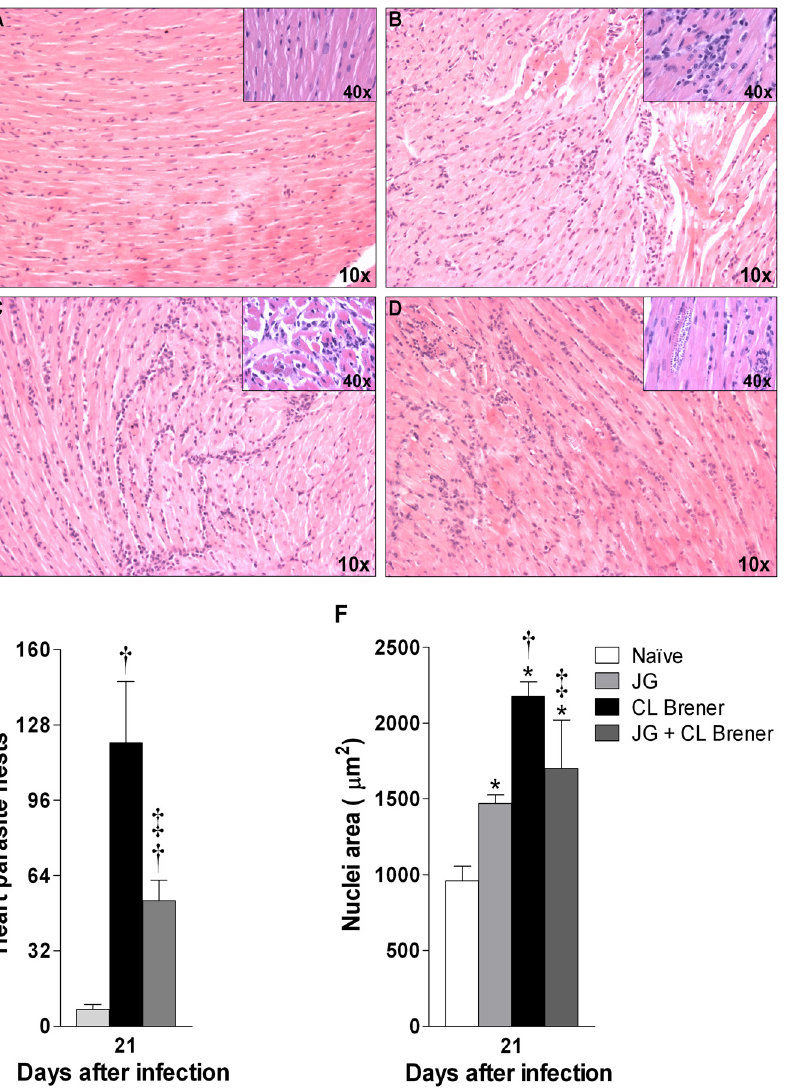
Figure 4. Heart histopathology, morphometric analysis and parasitism in BALB/c mice infected with JG and/or CL Brener. HE-stained representative myocardial sections from mice infected with 100 trypomastigotes of JG or CL Brener (single infection) or coinfected with 100 trypomastigotes of both T. cruzi populations in a 1:1 ratio via the intraperitoneal route were collected at 21 days p.i. (A–D) and were histopathologically analyzed in original magnifications of 10 6 or 40 6 (details). Total number of parasite nests (E) and nucleus area quantification (cellularity) were assessed using computer-aided morphometry (F), Symbols as follows: A or white bar: Naı¨ve mice; B or light gray bar: JG infected mice; C or black bar: CL Brener infected mice; and D or dark gray bar: JG and CL Brener infected mice. a Represents number of parasite nests counted in three semi-consecutive sections. Values are expressed as the mean 6 SEM of three mice per group (representative of two independent experiments). *, { and { represent P , 0.05 when compared with naı¨ve, JG and CL Brener mice groups,